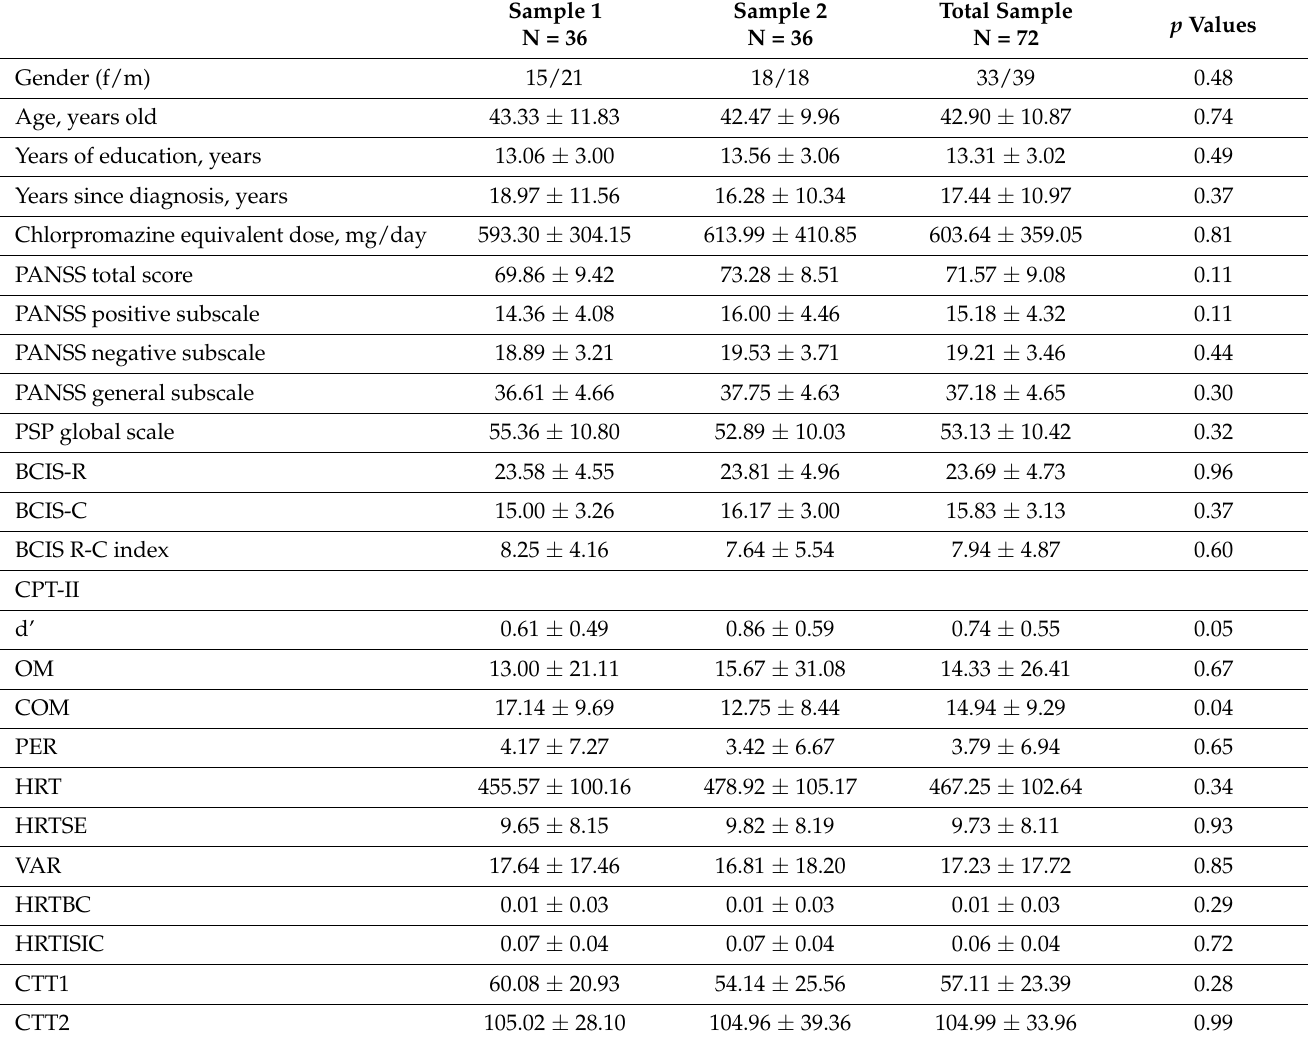
Table 1. Sociodemographic and clinical characteristics of the participants. Sample